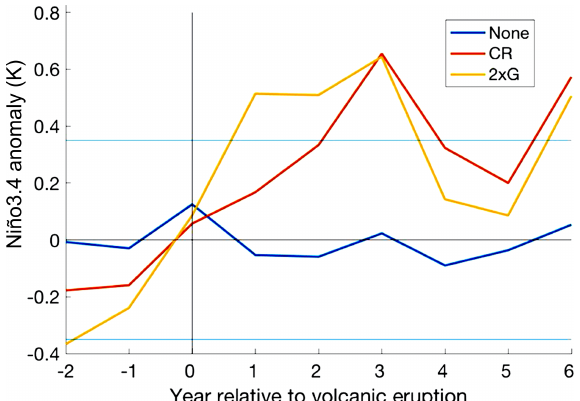
Figure 6. Multi-ensemble and multi-volcano mean NINO3.4 re- sponse to CR and “None” ensemble forcing groups and multi- volcano mean DMI response to the 2 × G forcing group over DJF. Significance was tested using the 0.6 standard deviation threshold (horizontal blue lines), and by comparing the CR and 2 × G ensem- bles to those without volcanic forcing.